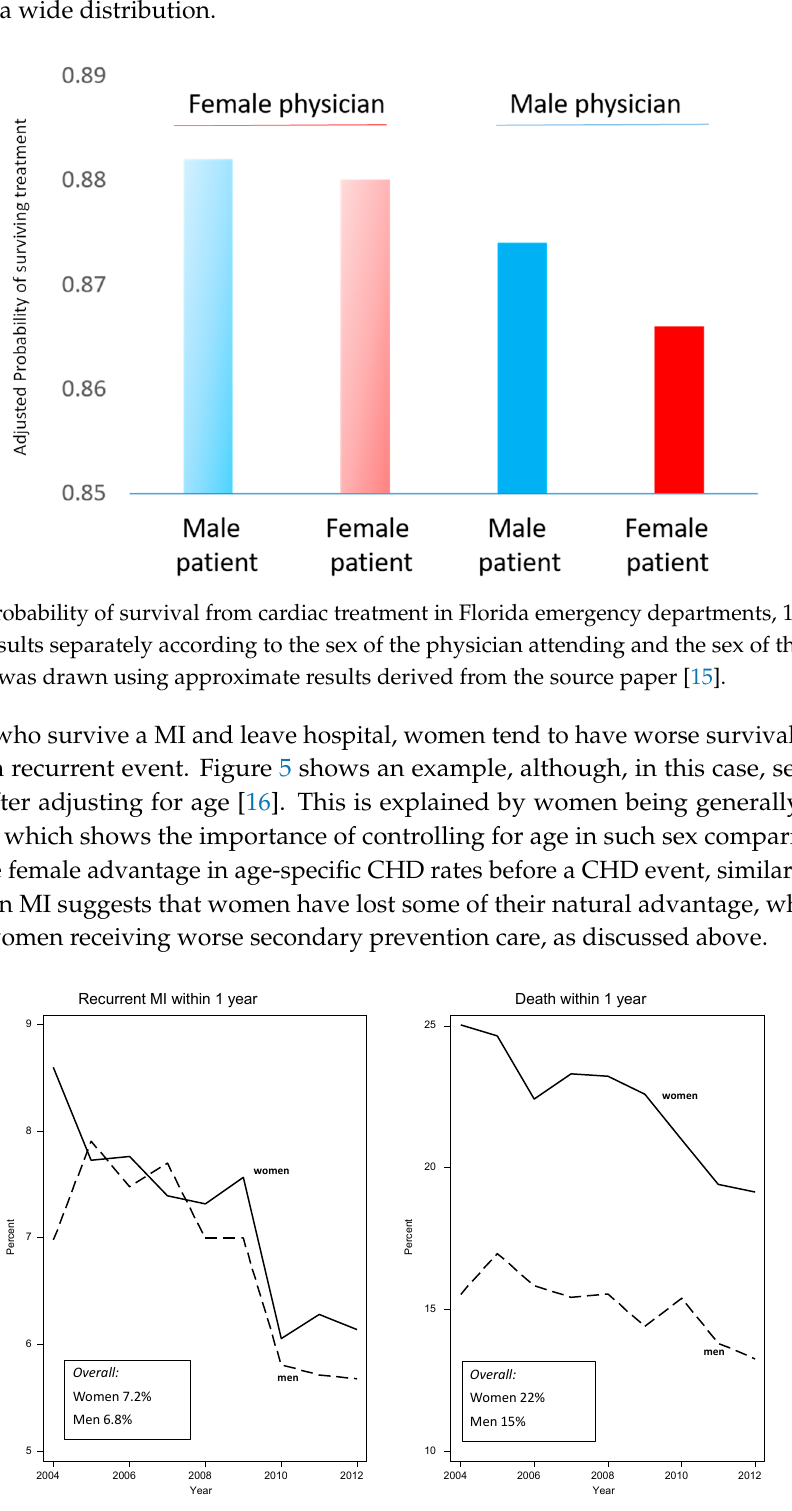
Figure 5. Percentage of myocardial infarction (MI) patients experiencing a recurrent event and percentage of patients dying within one year after discharge from New South Wales hospitals, 2004–2014, by sex ( n = 89,529).